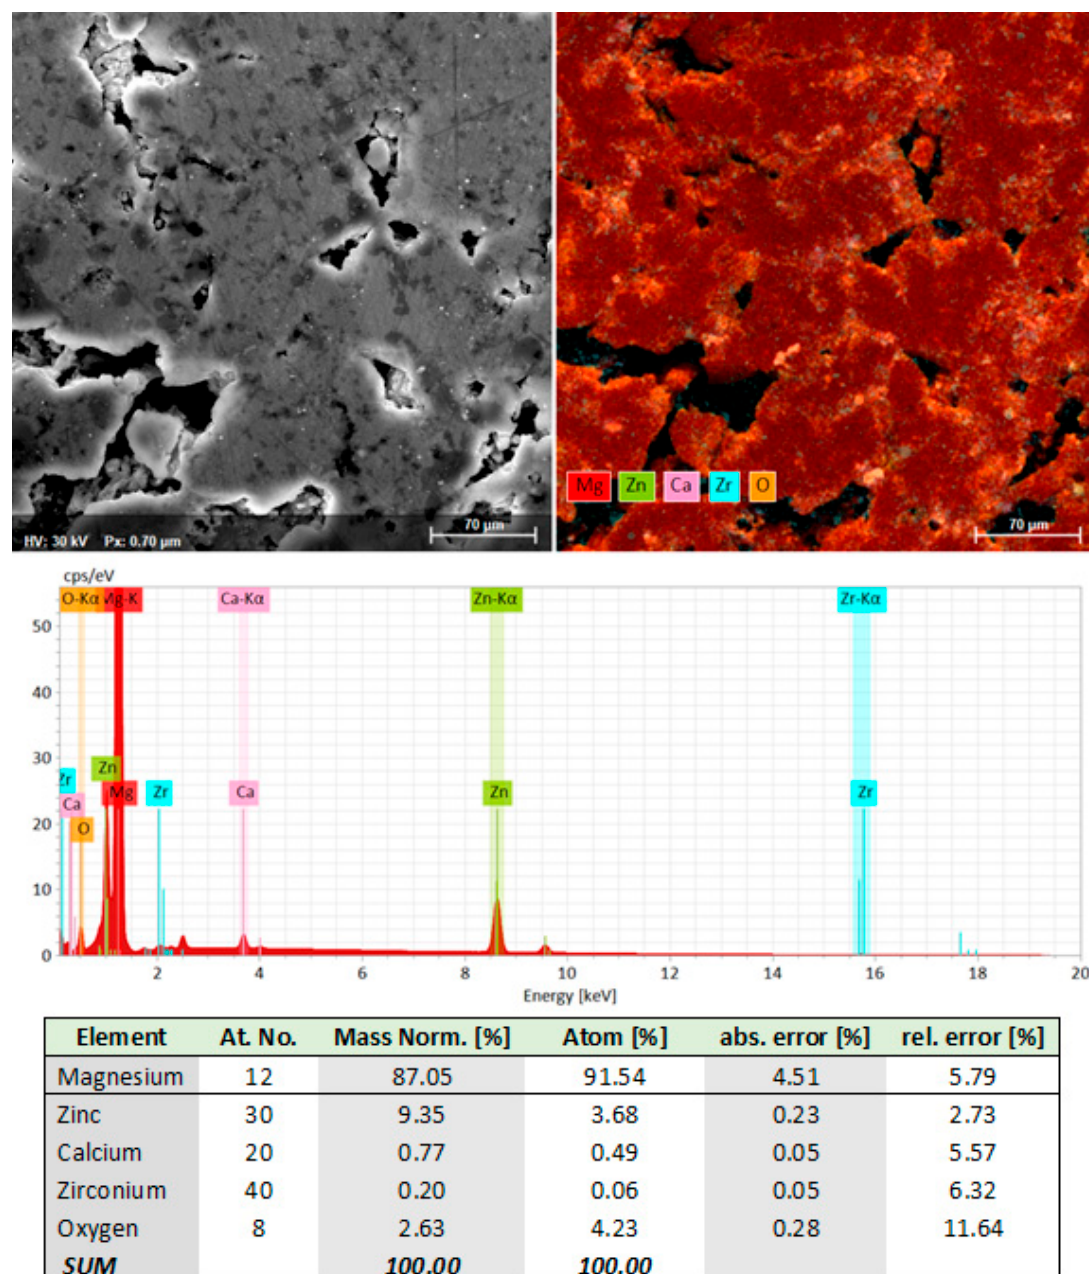
Figure 11. The SEM-EDS image and compositional results for the L-PBF-processed Mg-10Zn-0.8Ca- 0.5Zr alloy.